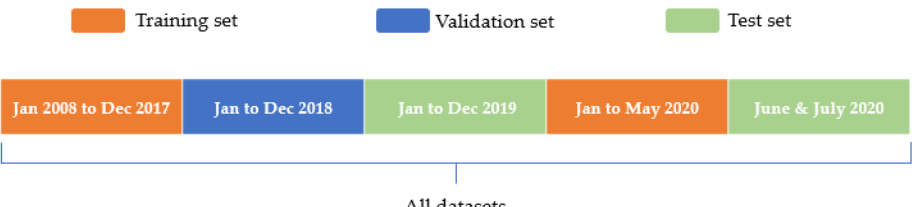
Figure 7. Fixed test set strategy. Source: Authors’ elaboration.